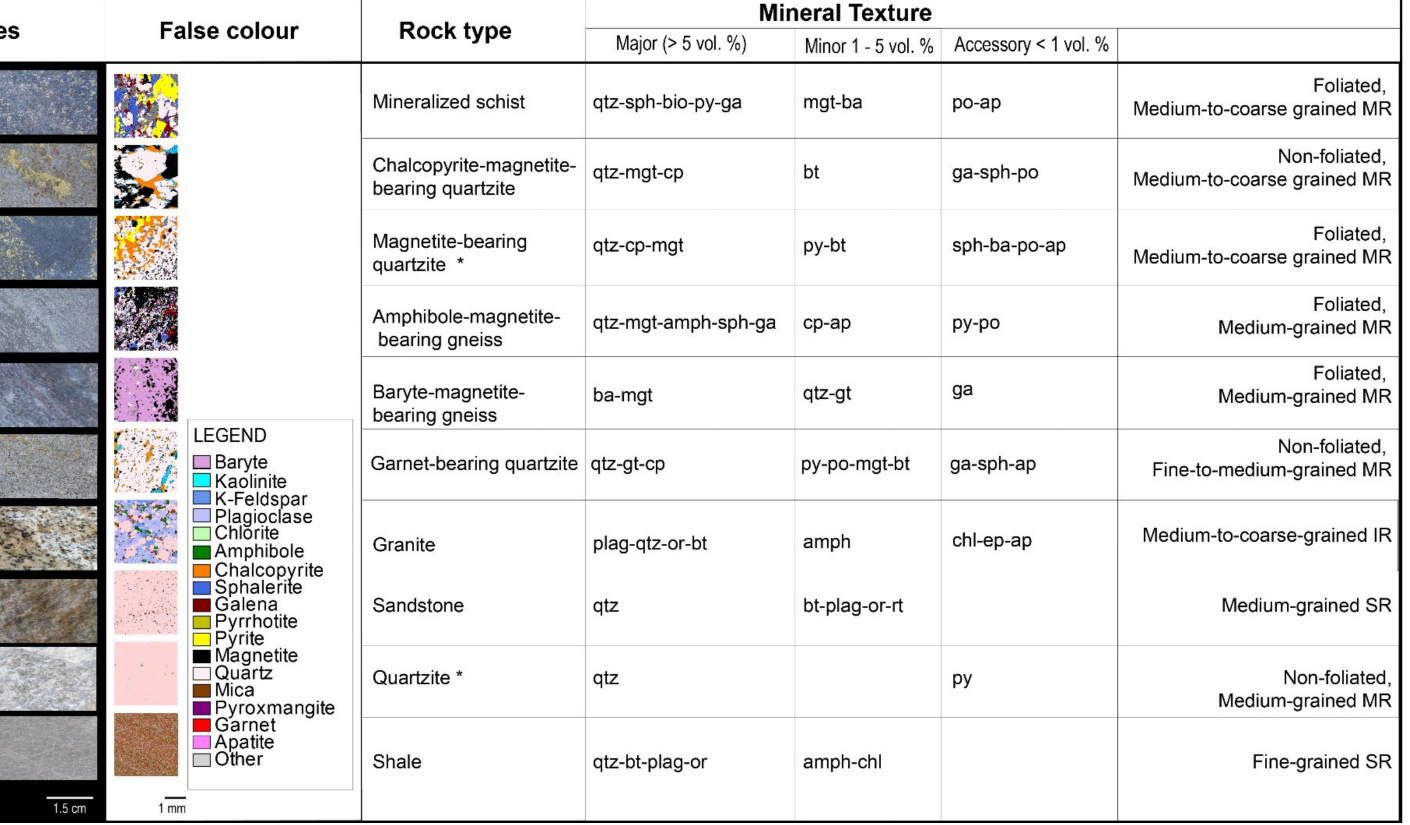
Figure 3. Photographs of the drill core samples, accompanied by false colour field images (QEMSCAN) and mineral texture descriptions for each rock type. Mineral abbreviations: amphibole (amph), apatite (ap), baryte (ba), biotite (bt), chalcopyrite (cp), chlorite (chl), epidote (ep), galena (ga), garnet (gt), magnetite (mgt), orthoclase (or), plagioclase (plag), pyrite (py), pyrrhotite (po), sphalerite (sph), rutile (rt) and quartz (qtz). Rock abbreviations: igneous rock (IR), metamorphic rock (MR) and sedimentary rock (SR). * Indicate the two reference